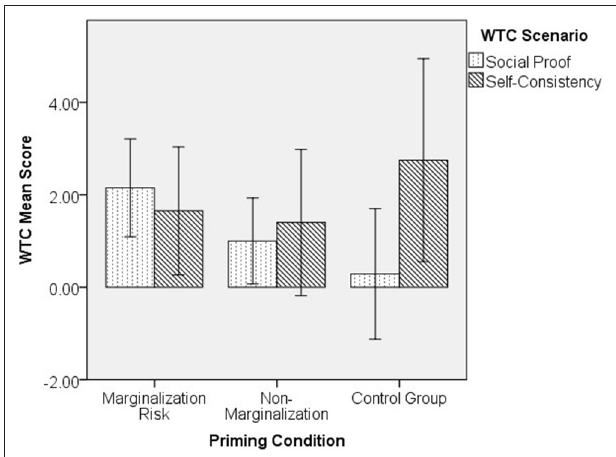
FIGURE 3 | Priming conditions and compliance motivation among Freeters.